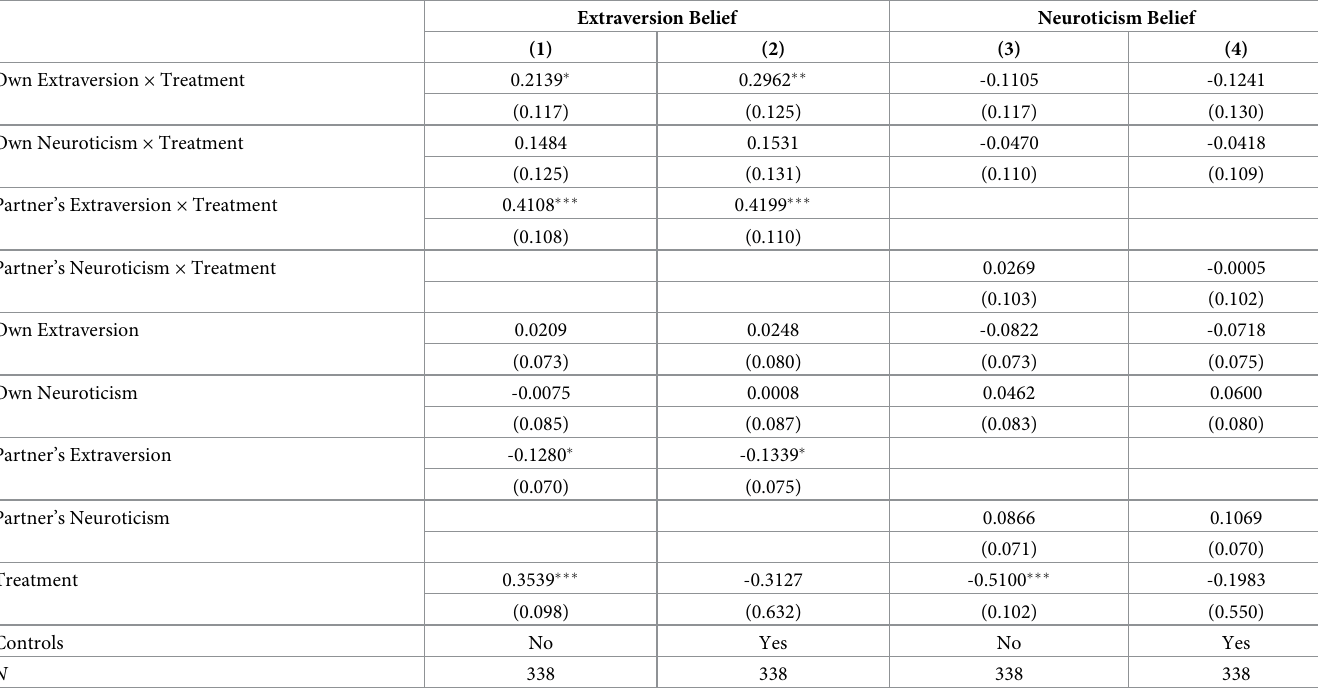
Table 1. Impact of own personality and partner’s true personality on beliefs about partner’s